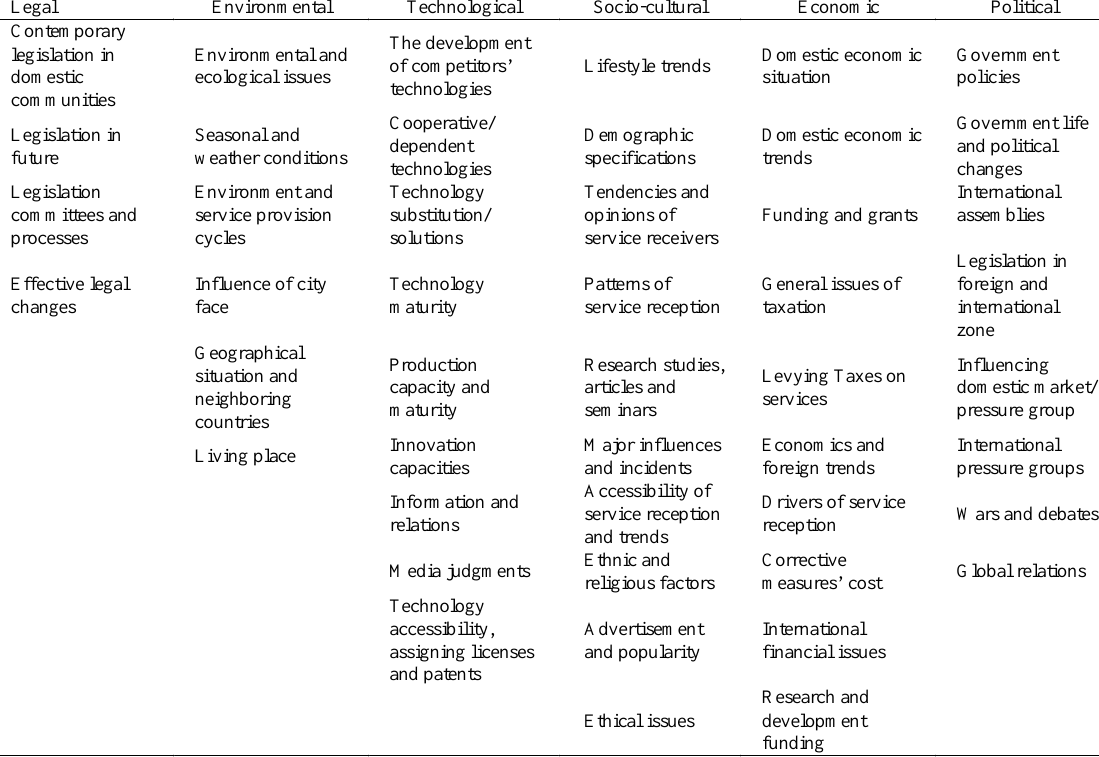
Table 1: Categorization of Investigated Factors in PESTEL